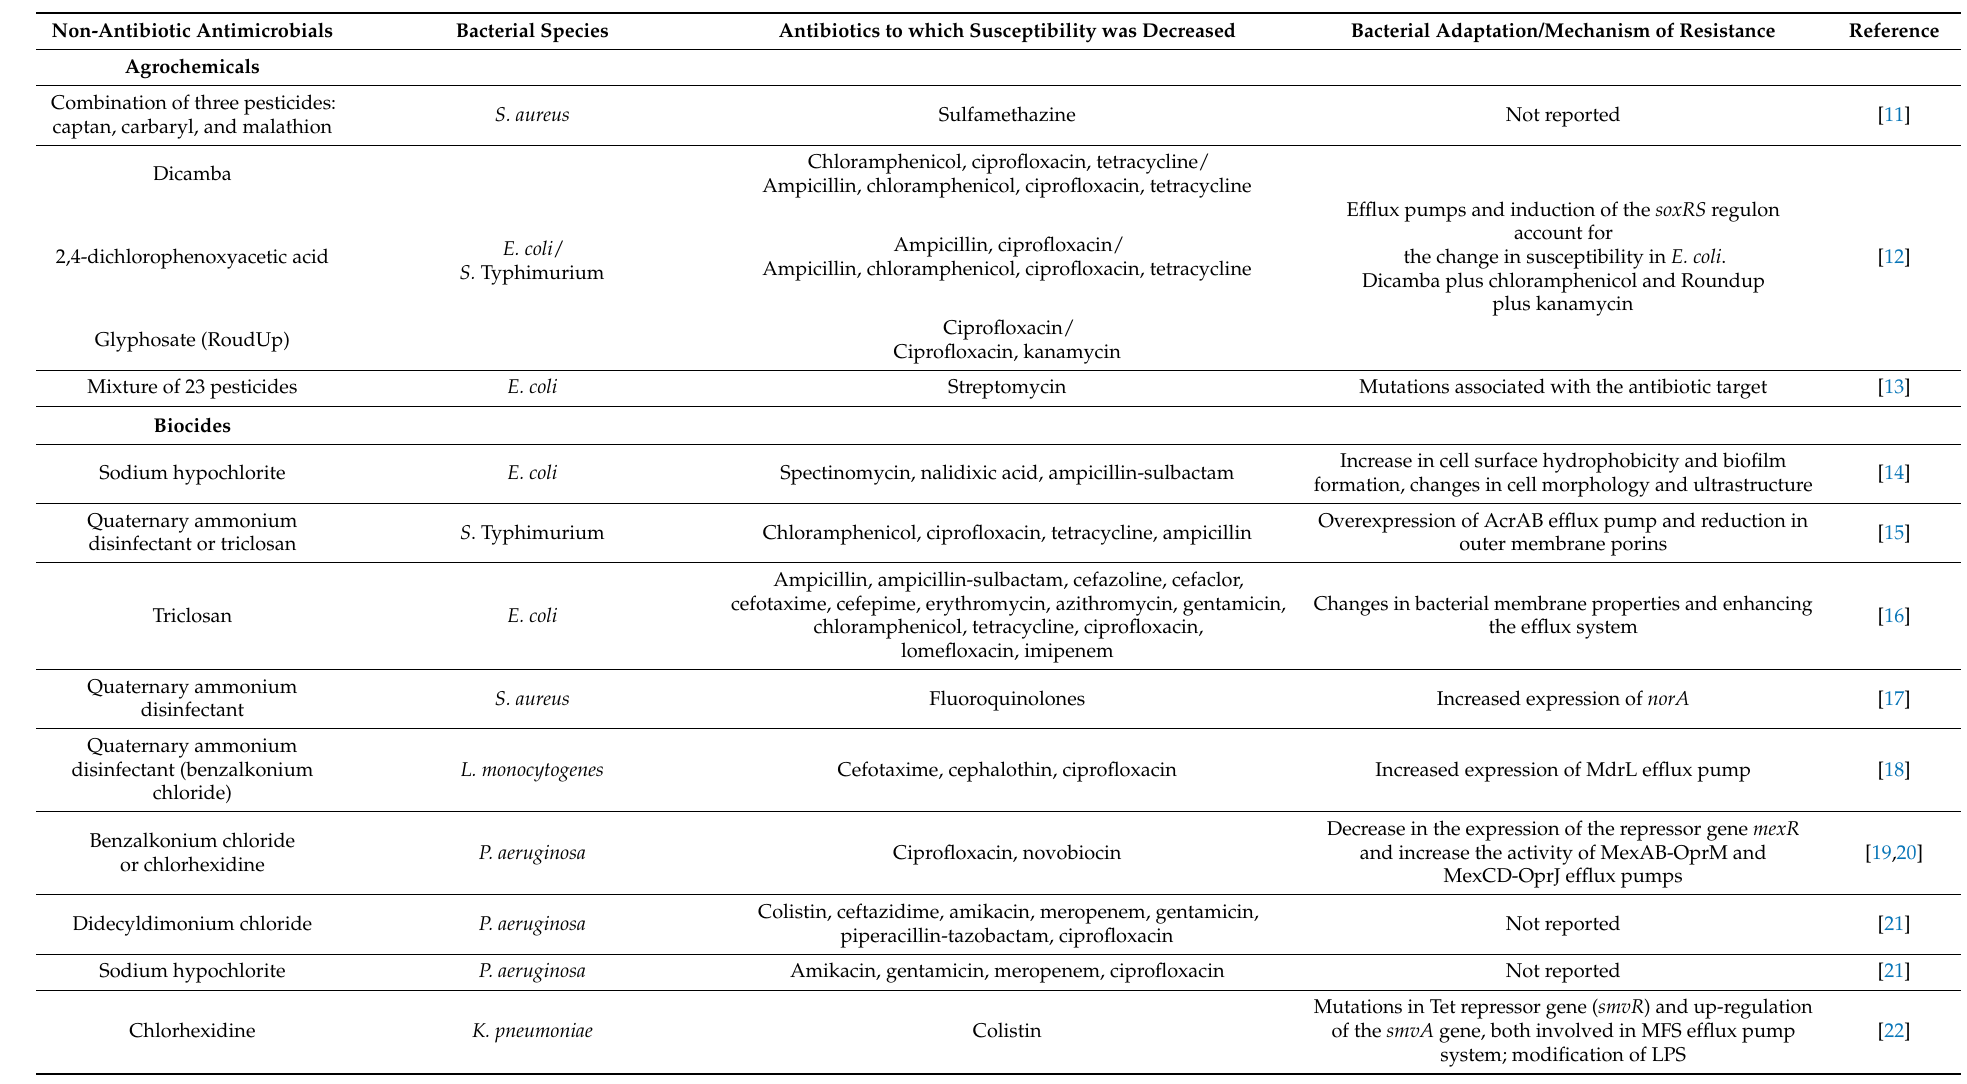
Table 1. Examples of bacterial cross-adaptation to antibiotics induced by exposure to non-antibiotic